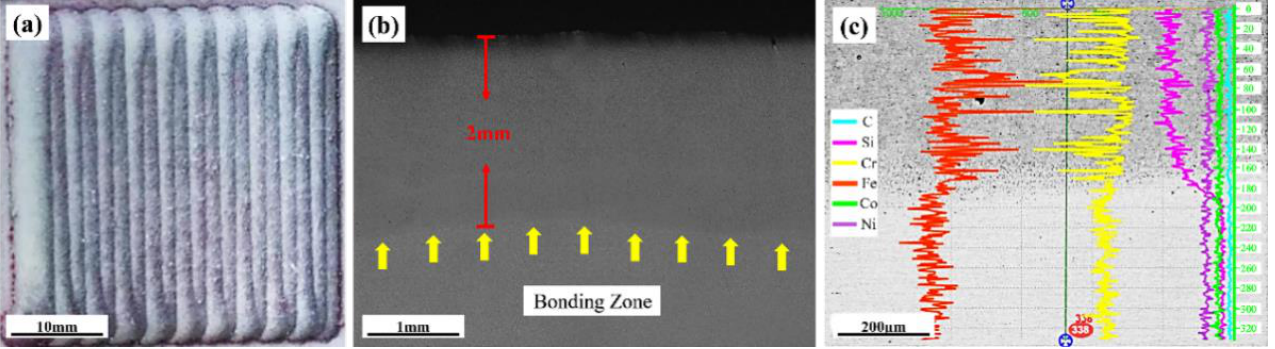
Figure 2. Laser cladded sample ( a ), FeCrSiNiCoC coating and substrate cross section morphology ( b ), and longitudinal element distribution ( c ).